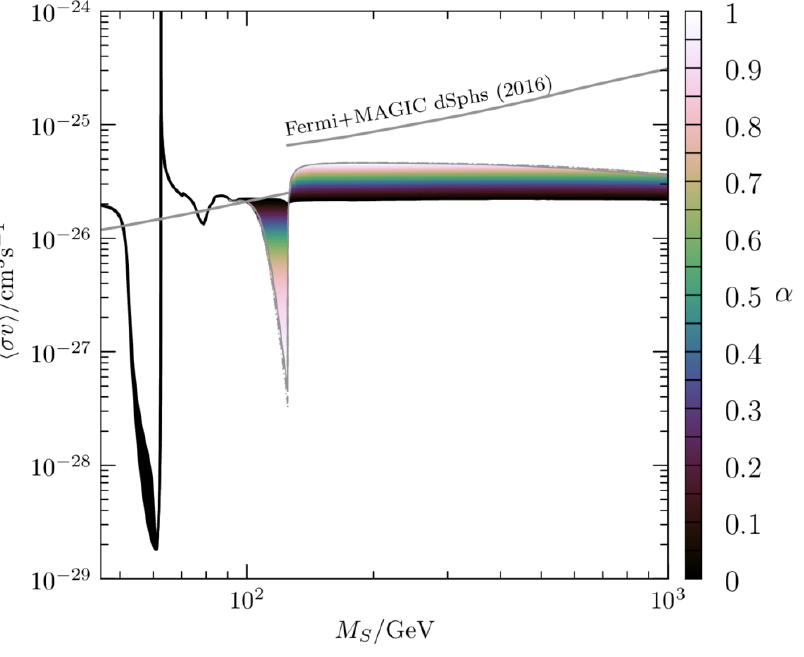
Figure 4 . The indirect detection signal colour-coded for the semi-annihilation fraction (cid:11) at the freeze-out as in (cid:12)gure 3. The observational bound from the combined (cid:13) -ray events from the sky region of the dwarf satellite galaxies (dSphs) measured by the Fermi LAT and MAGIC experi- ments [103]. The sharp step at M S M h is due to the fact that the dominant annihilation channel (cid:24) of S switches from the b (cid:22) b channel at below the Higgs mass to the hh channel above M h